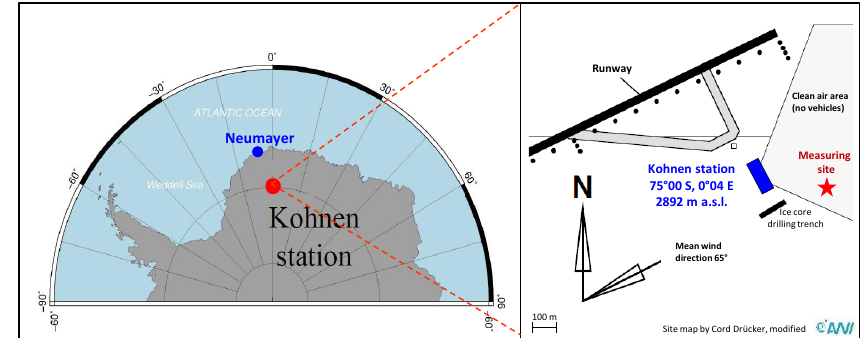
Figure 1. Location of Kohnen station (Dronning Maud Land, DML) and site plan of the station